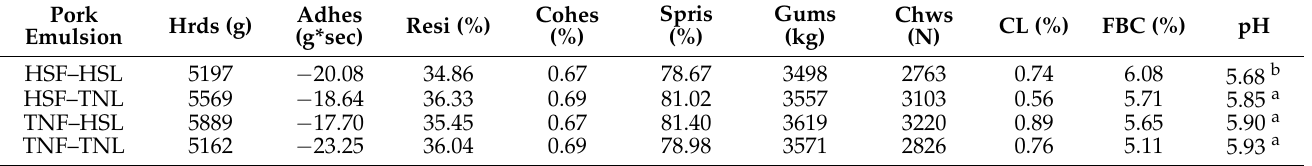
Table 4. Textural profile analysis, cooking loss and fat-binding capacity of pork sausage emulsions.